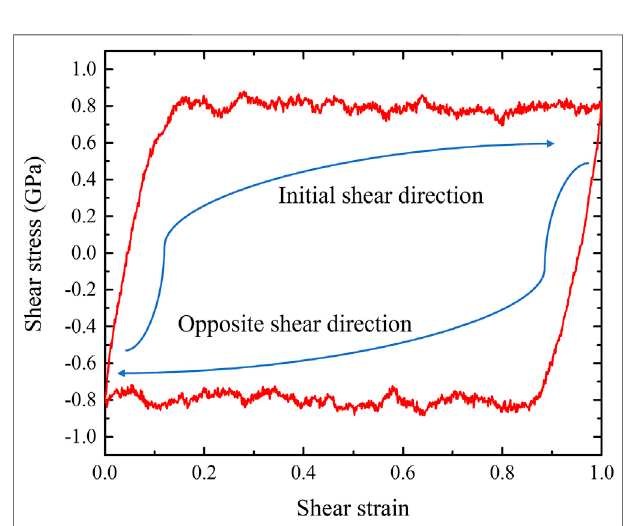
FIGURE 11 | The Bauschinger effect in L-phase after reaching to the state of plastic fl ow.